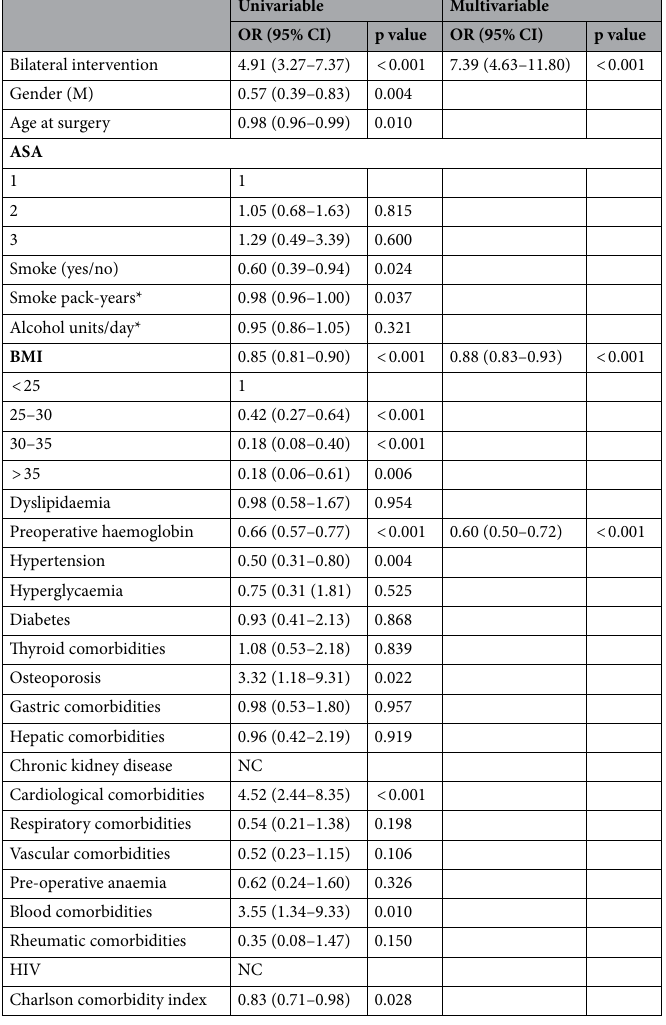
Table 3. Univariable and multivariable logistic regression assessing risk factors for postoperative